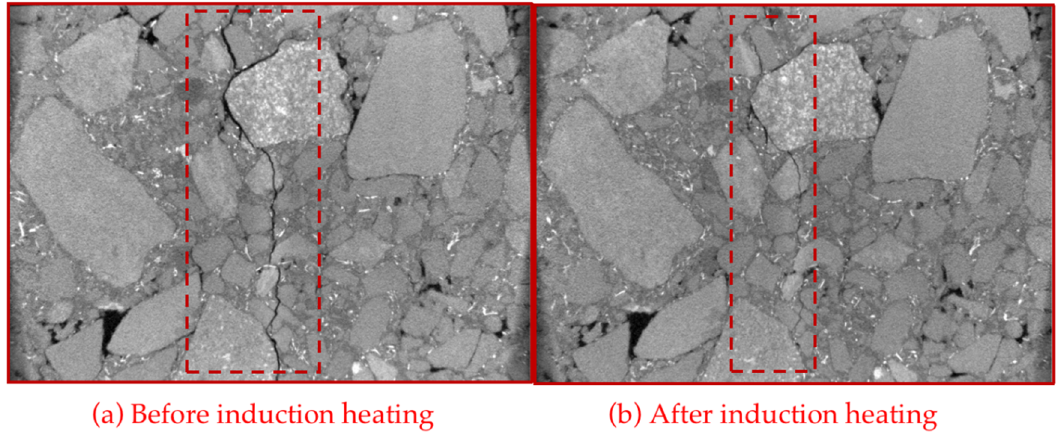
Figure 16. CT scanning figure of SS-6 before and after induction Figure 16 CT scanning figure of SS-6 before and after induction heating.